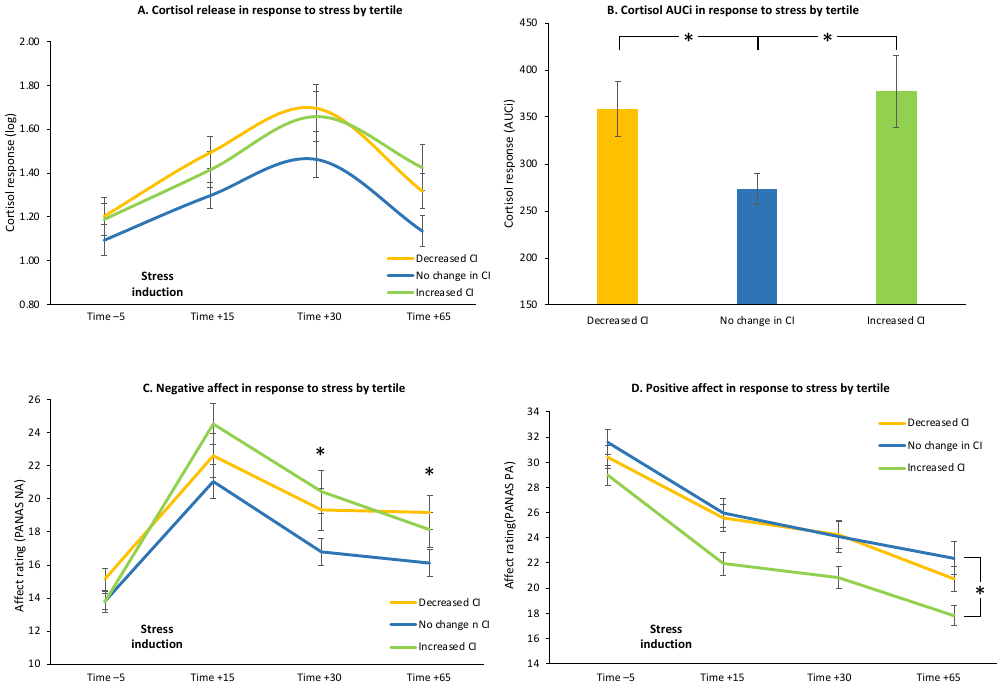
Figure 5. Response to stress by choice impulsivity change group. Changes in cortisol release ( A ), cortisol AUCi ( B ), negative affect ( C ) and positive affect ( D ) throughout the experimental session as a function of change in choice impulsivity group. Compared to participants that exhibited no substantial change in their choice impulsivity after stress, those that exhibited stress-induced change in their impulsive choice behavior also exhibited more stress-induced cortisol release and more negative affect, regardless of the direction of the behavioral change. *— p < 0.05. Error bars represent standard error.